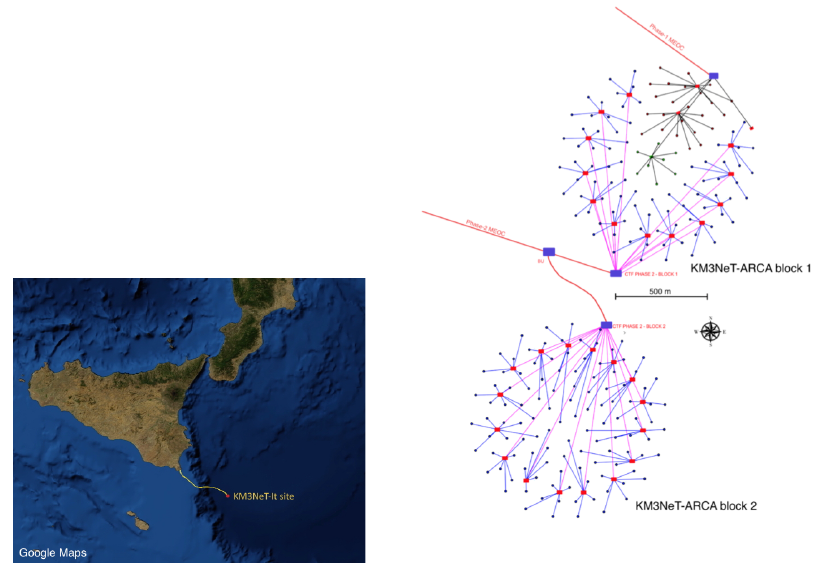
Figure 4. Left: map of the Mediterranean Sea south of Sicily, Italy. The location of the KM3NeT-Italy is indicated. Right: layout of the ARCA detector, depicting the two building blocks, cables and connection